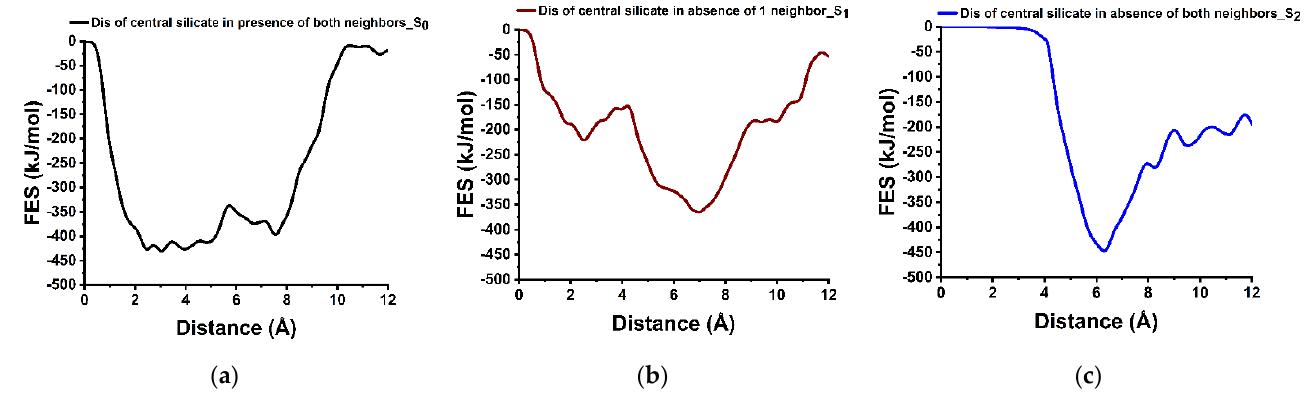
Figure 6. The representative dissolution profile (free energy surface) of the central silicate (marked yellow in Figure 1III, S 0 ) ( a – c ), from (100) facets of β -C 2 S in the different scenarios: before and after removal of one and two silicate neighbors at 298 K.